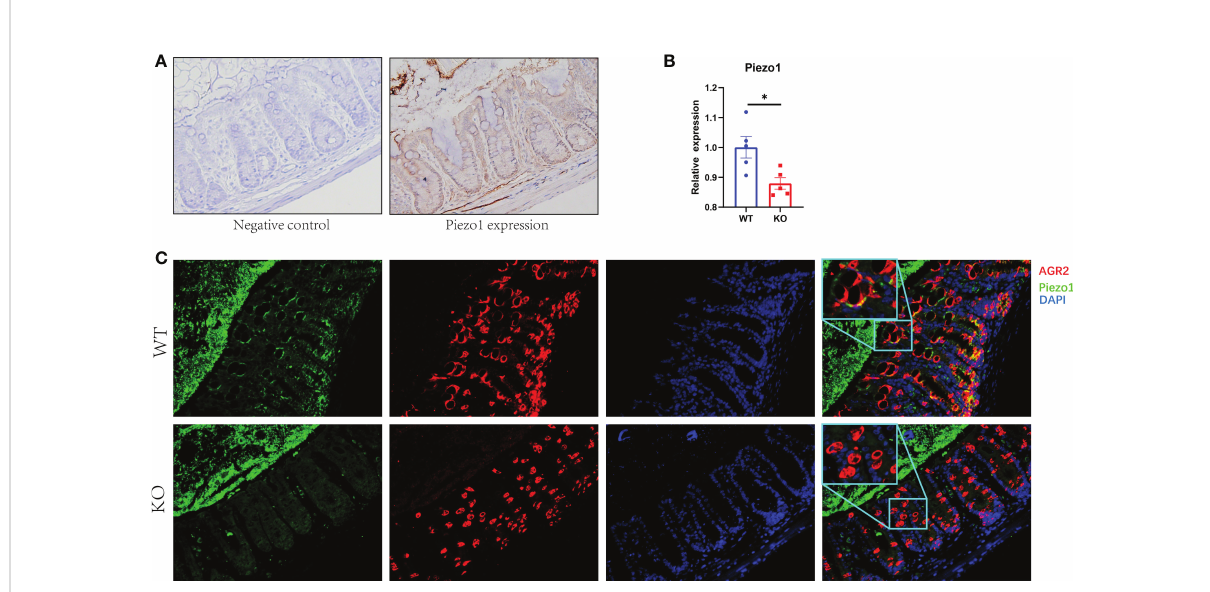
FIGURE 1 Expression of Piezo1 in colon. (A) Expression of Piezo1 in colon. (B) Relative mRNA expression of Piezo1. (C) The co-localization of AGR2 and GC Piezo1 in colon (400×). Data are expressed as the mean ± SEM (n =4-5). *p <